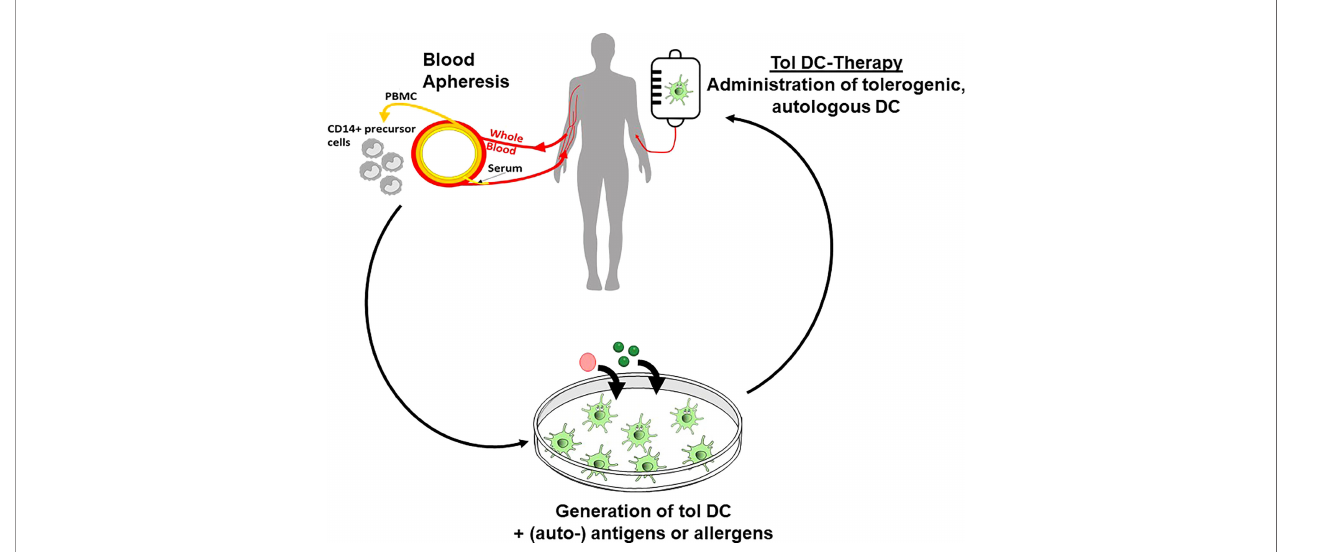
FIGURE 3 | Tolerogenic DC in clinical applications. Ex vivo generation of tolerogenic DC starts with isolation of CD14 + monocytic precursor cells from the peripheral blood of the patients. After subsequent in vitro culture in the presence of tolerogenic agents and loading with (auto-) antigens, the tolerogenic DC are re-injected into the patients to affect the in fl ammatory immune reaction in allergic and autoimmune disorders or in transplantation